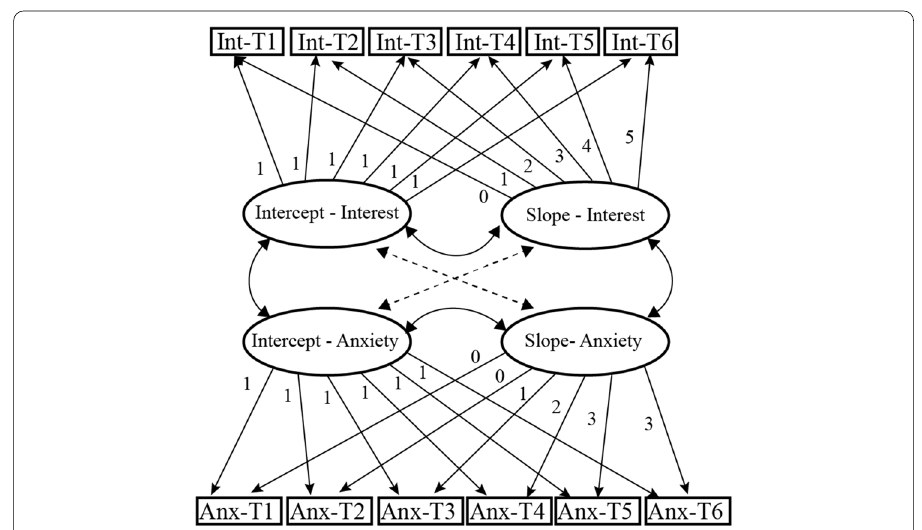
Fig. 2 Unconditional parallel latent growth model. Int interest, Anx anxiety. Covariance between observed variables at same timepoints are not drawn for simplification. Dotted lines denote p > .05. Solid lines all significant